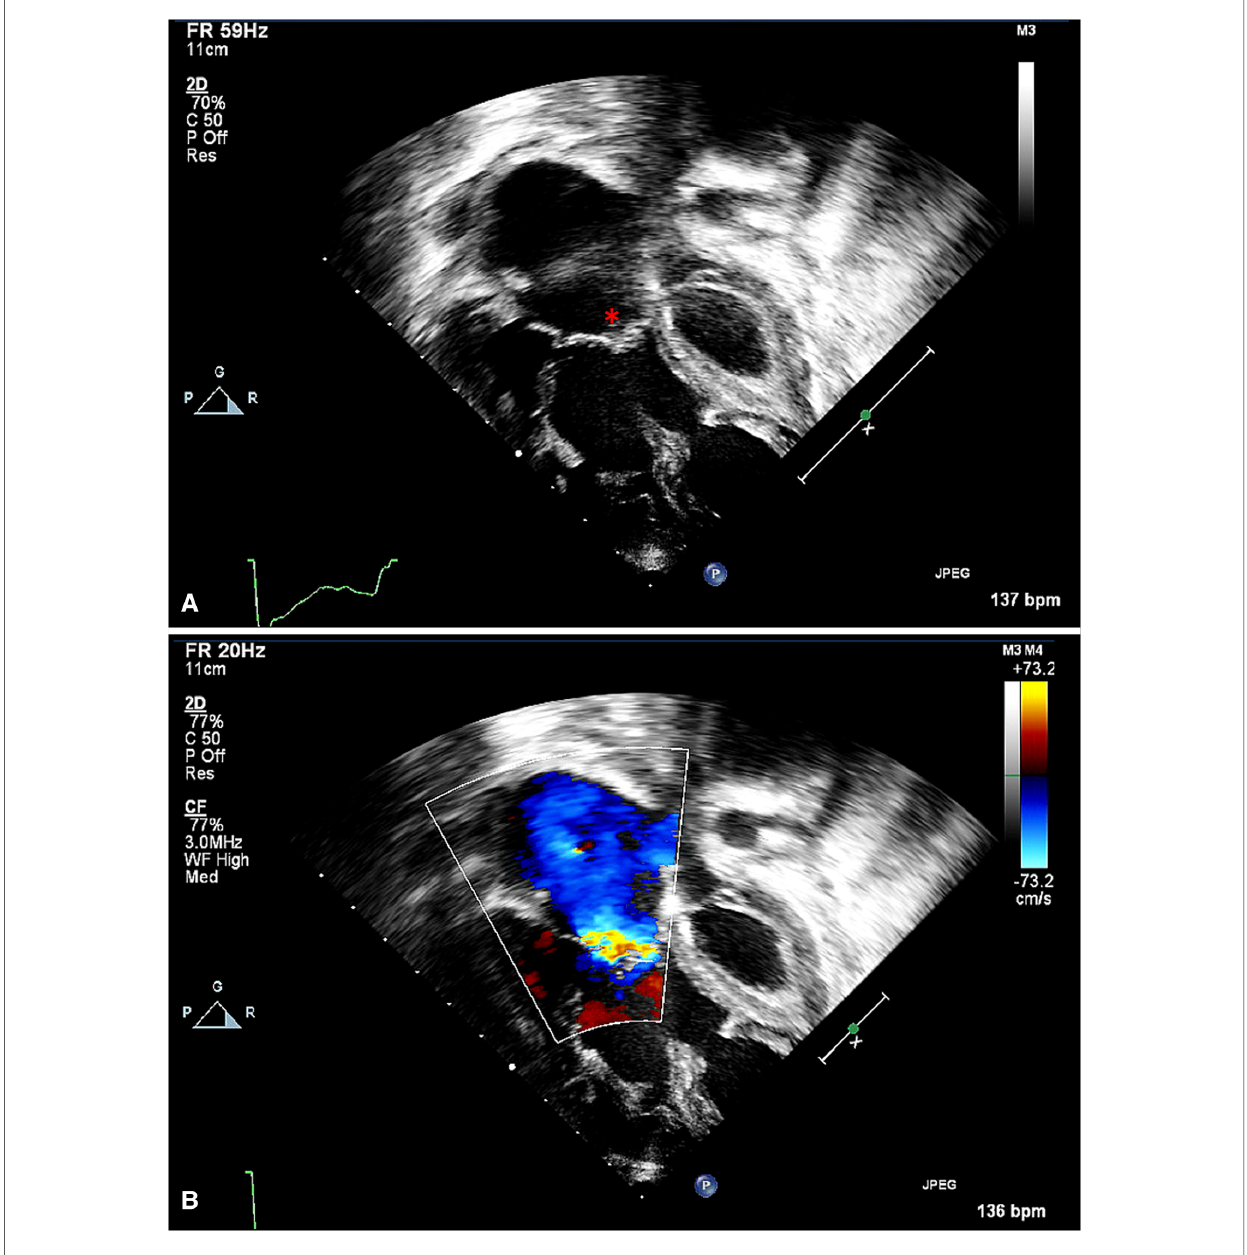
FIGURE 3 Apical view of tricuspid valve, with annular dilatation. ( A ) The valve ’ s coaptation area is reduced (*). ( B ) The color Doppler interrogation indicates a broader area of regurgitation, through multiple fenestrations in addition to the central area of